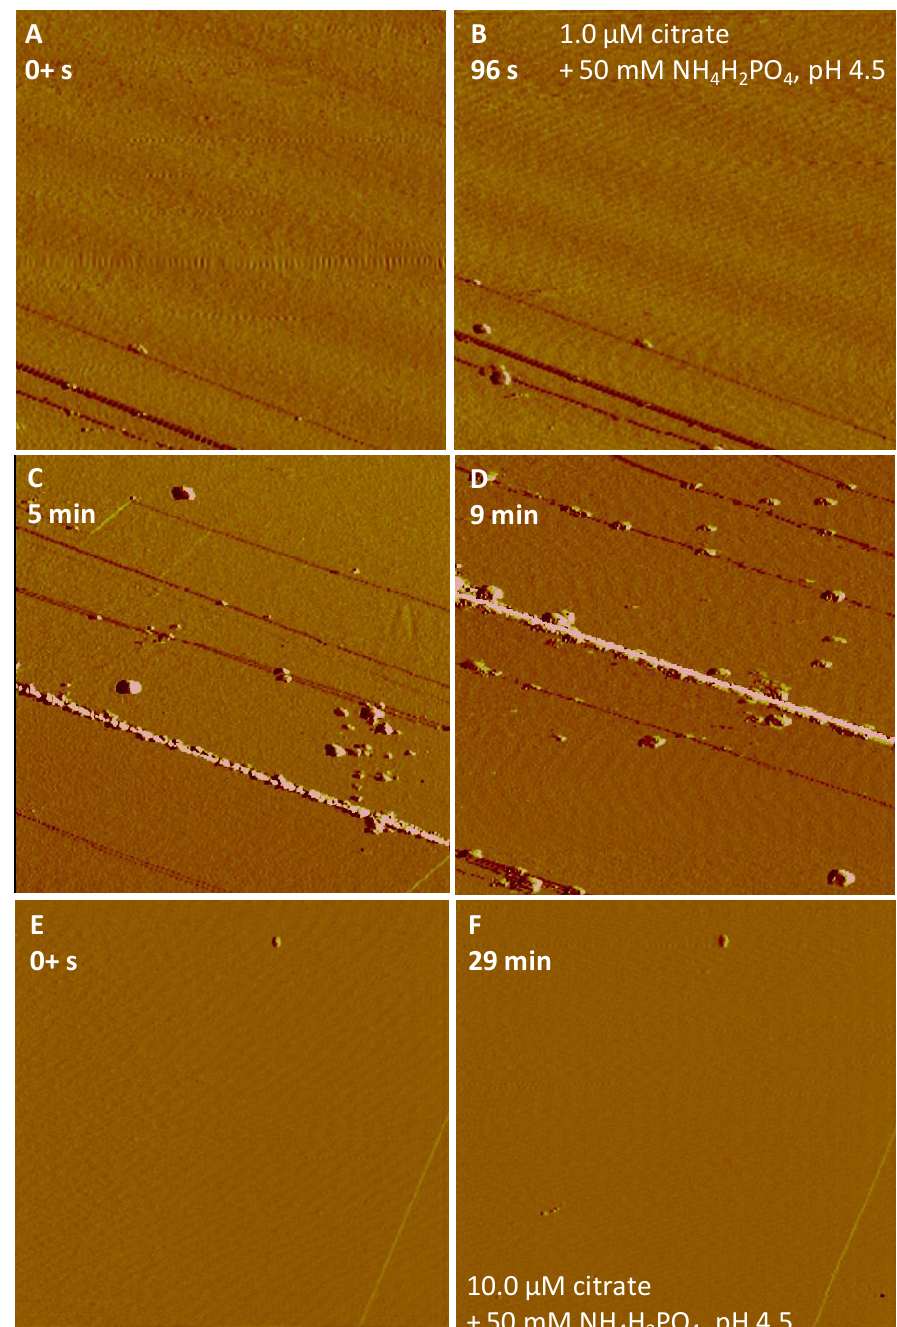
Figure 6. Nucleation kinetics of Fe-P phases on hematite in the presence of ( A – D ) 1.0 μM citrate and ( E , F ) 10.0 μM citrate with 50 mM NH 4 H 2 PO 4 at pH 4.5. AFM images, 5 μm × 5 μm.